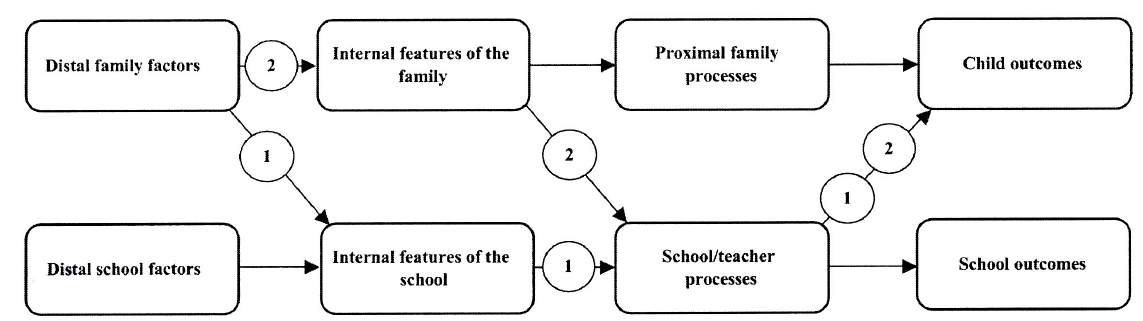
Figure 3. Conceptual model for multi-level interactions between family and